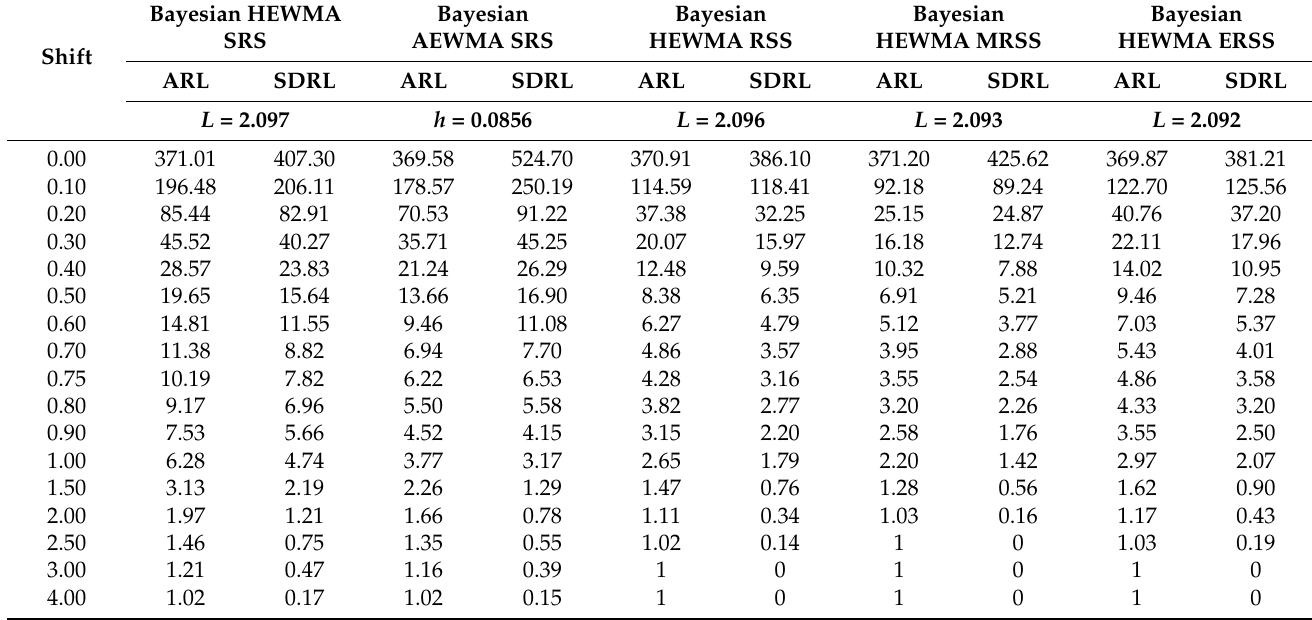
Table 5. The ARL and SDRL values of Bayesian HEWMA and Bayesian AEWMA control chart